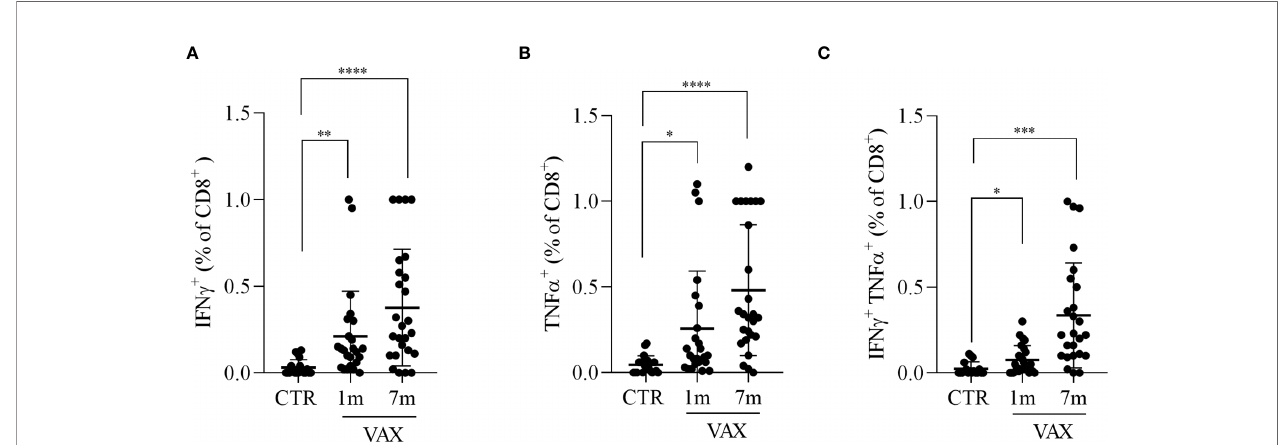
FIGURE 3 | Analysis of CD8+ T lymphocytes response to Spike derived peptides. Total PBMCs were stimulated in vitro with a pool of peptide derived from Spike (Wuhan variant). After 6 hours incubation in the presence of brefeldin A during the last 4 hours, PBMCs were stained and analyzed by fl ow cytometry for the production of INF g (A) , TNF a (B) , or for the simultaneous production of INF g and TNF a (C) in CD8+ T cells. Cells from immunized subjects, analyzed at 1 and 7 months after vaccination cycle completion, were compared with cells from not-vaccinated controls (CTR). Data were analyzed using Mann-Whitney U-test *p<0.05; **p<0.01; ***p< 0.001;